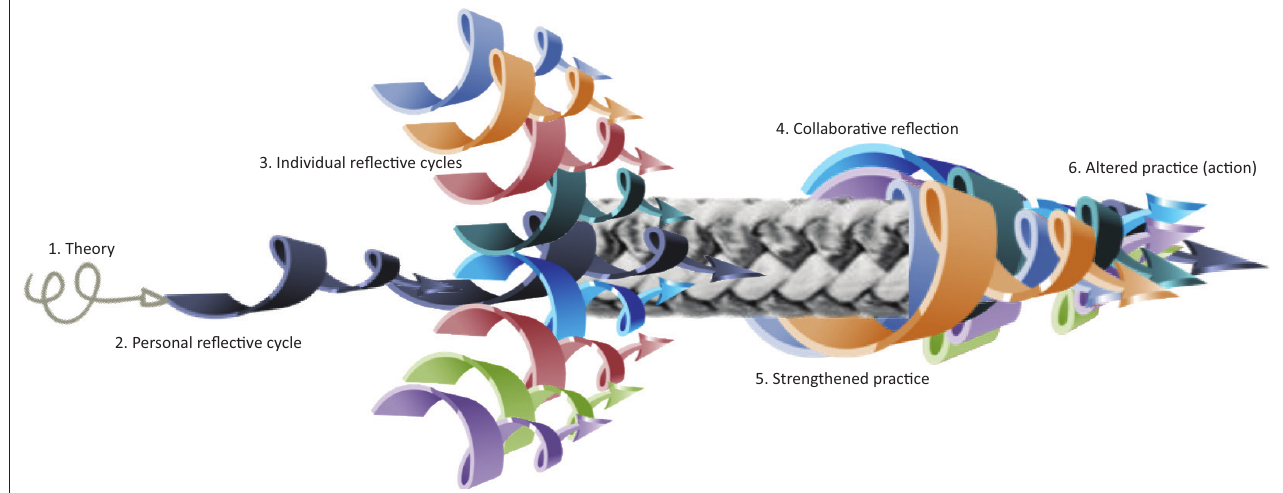
FIGURE 2: Participatory action research model.